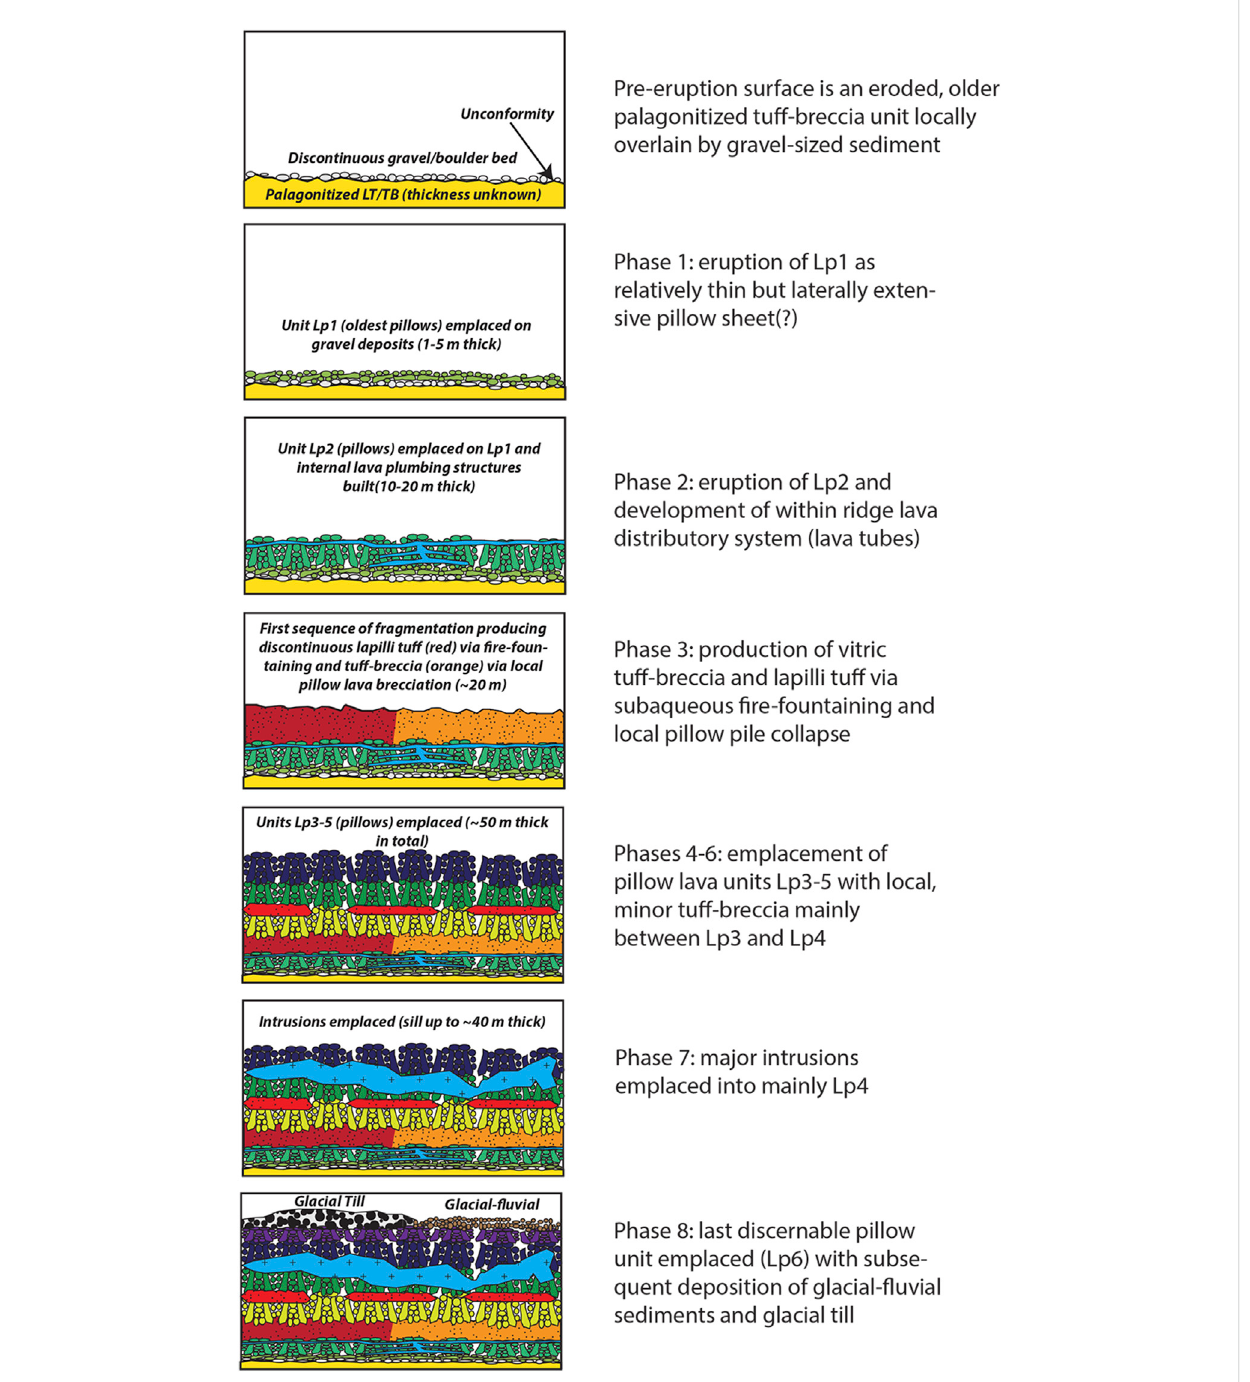
FIGURE 13 Formation sequenceforUndirhliðartindarbasedonexposuresinVatnskarðquarry.Panelsarelabeledwithmaineruptionevents.Unitcolorsarethe same as in the legend for Figure